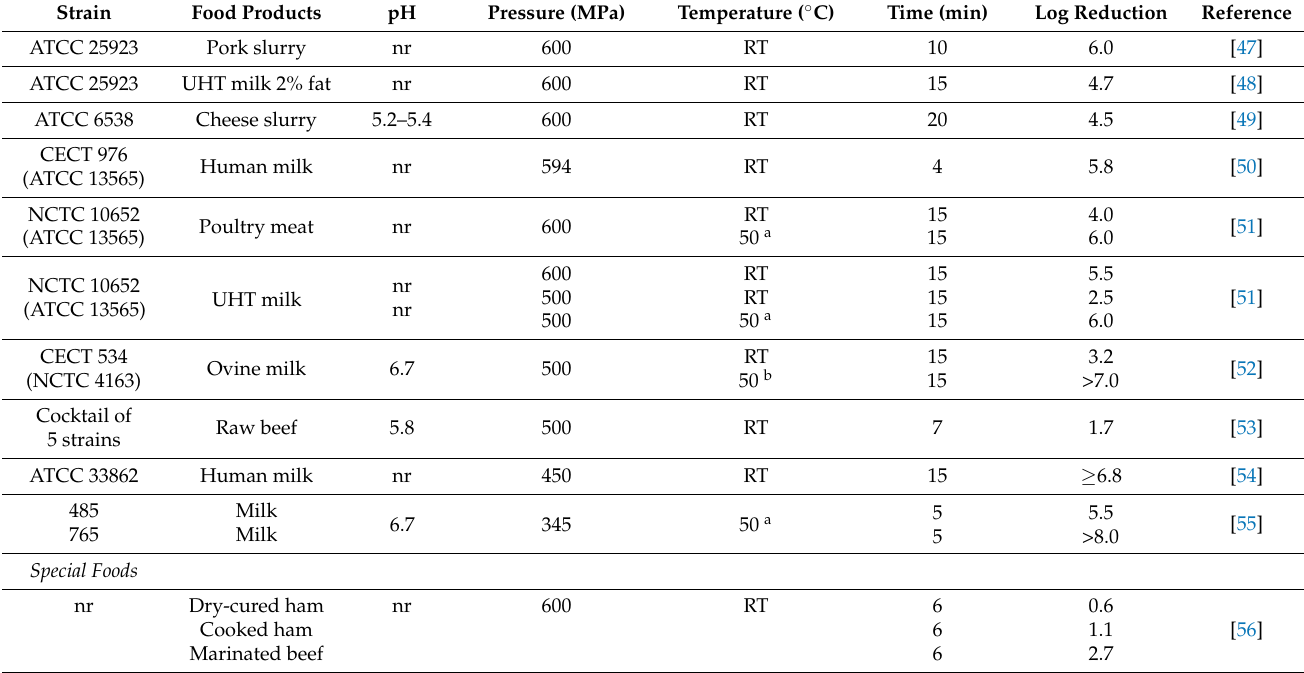
Table 1. Inactivation of Staphylococcus aureus in milks, cheese, and meat products by high pressure processing (HPP) and heat assisted HPP